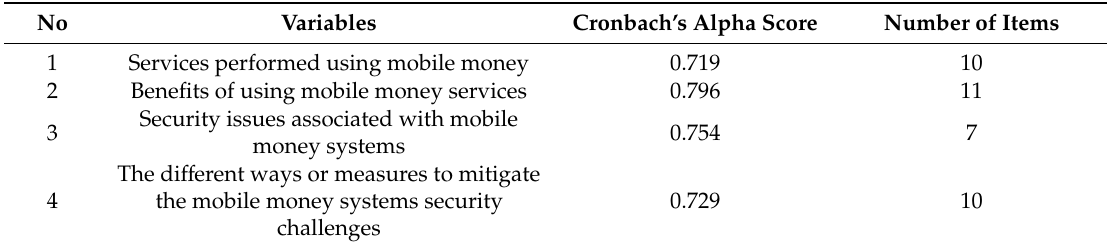
Table A1. Reliability Scores for Each